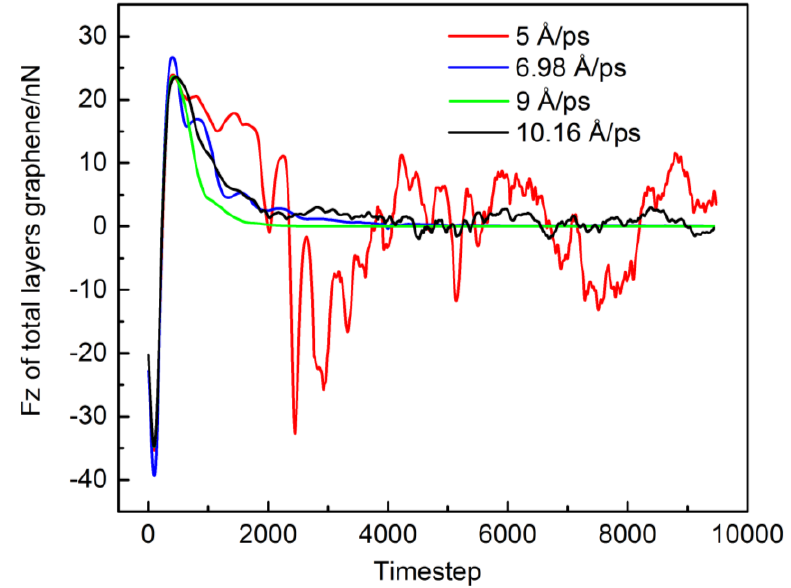
Figure 9. Fz to exfoliate the total number of layers of graphene varying with timestep.